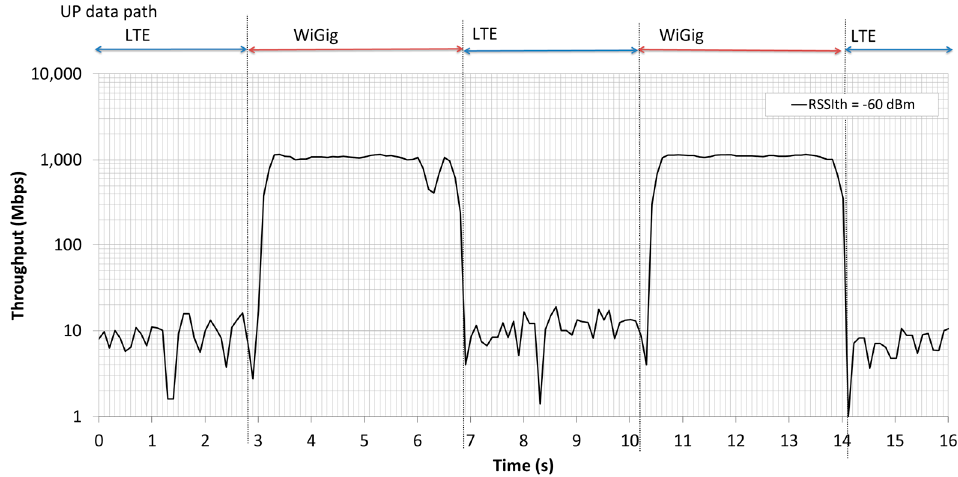
Figure 15. Transition of instantaneous UP throughput during LTE-WiGig handover.